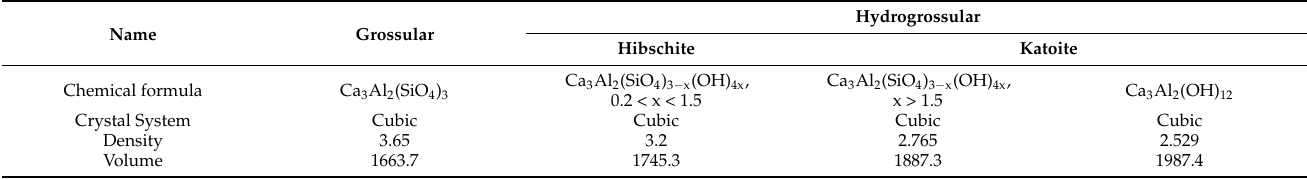
Table 5. The lattice parameters of hibschite and